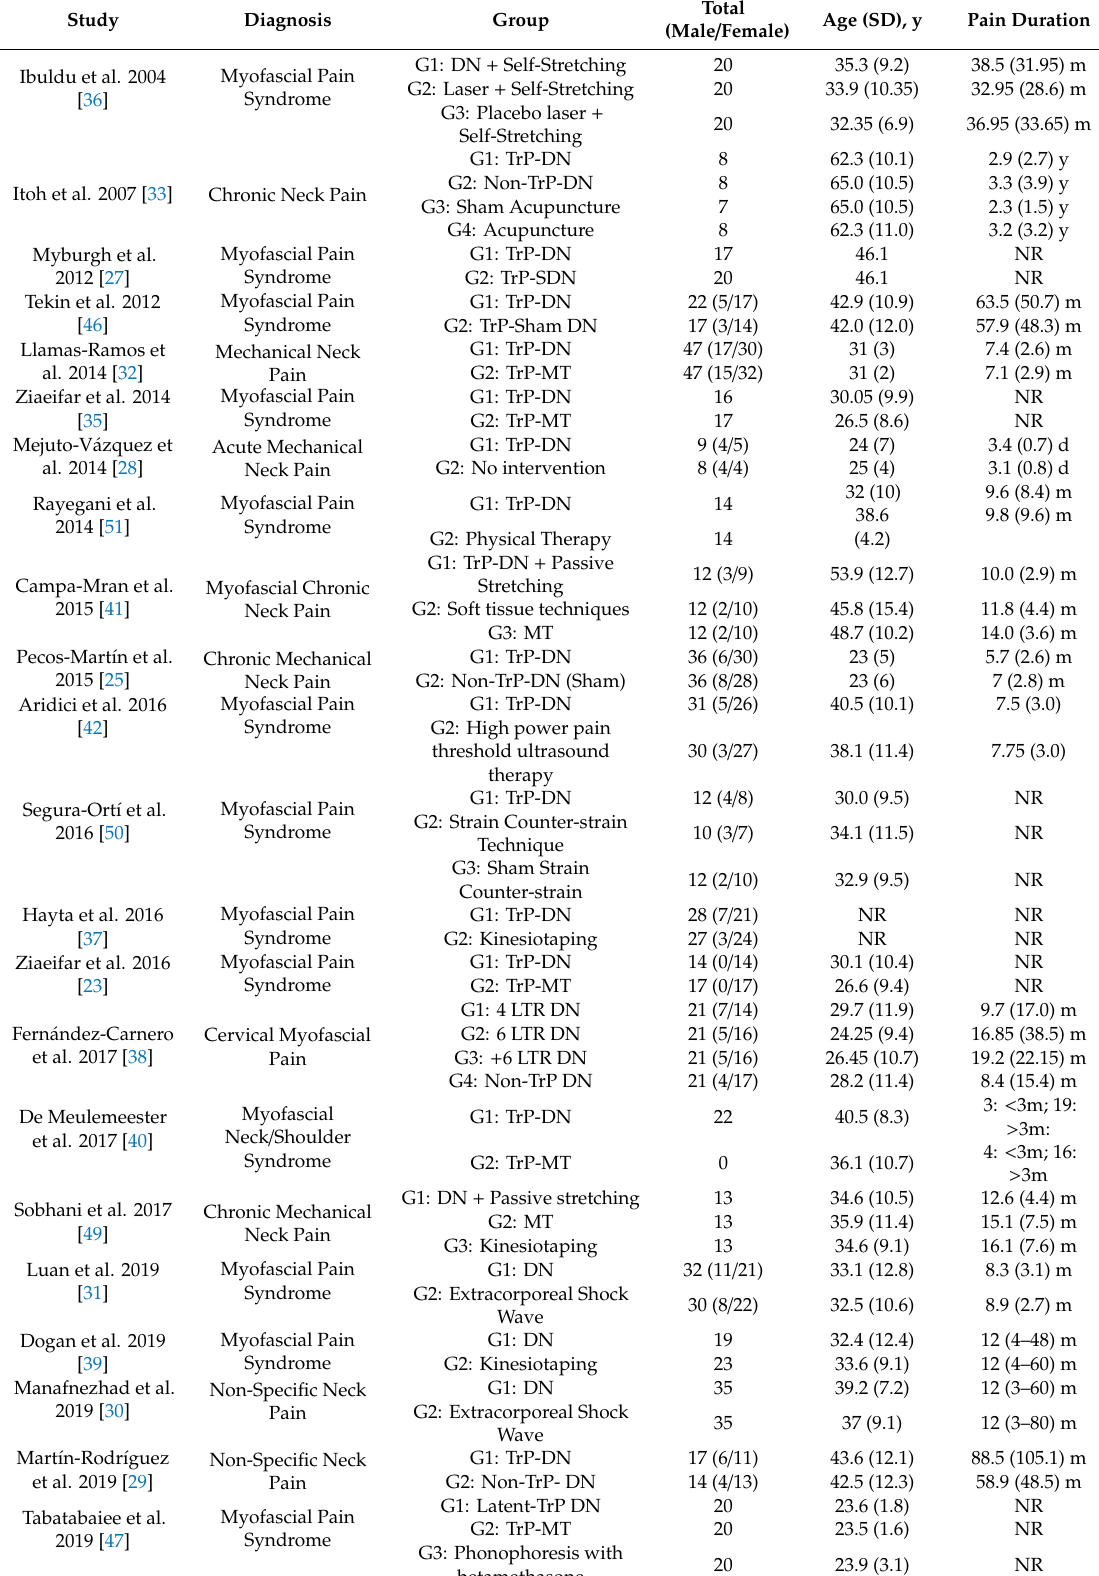
Table 2. Characteristics of the samples in each included